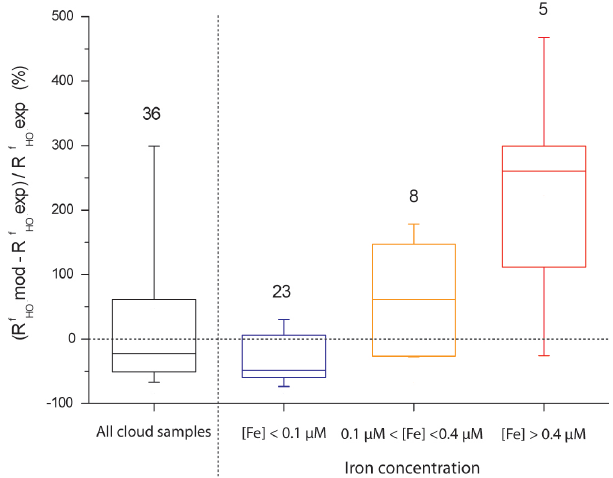
Figure 5. Distribution of the bias error for all cloud water samples Figure 4. Distribution of the bias error for all cloud water samples for the reference case and for two sensitivity tests performed with (black) and for cloud samples discretized as a function of different the model: (i) with the iron chemistry (photolysis of Fe(III) and iron concentration ranges (in colour). The bias error is defined by the Fenton reaction) neglected in the model; and (ii) with the iron (cid:113) mod − R f (cid:113) exp) /R f (cid:113) exp (in %). The number of the ratio ( R f chemistry neglected and the new photolysis rate constants obtained HO HO HO samples analysed is indicated above each boxplot. The bottom and from experimental measurements implemented in the model. The top lines correspond to the 25th and 75th percentiles, respectively. (cid:113) mod − R f (cid:113) exp) /R f (cid:113) exp bias error is defined by the ratio ( R f HO HO HO The full line represents the median values. The ends of the whiskers (in %).The number of samples analysed is indicated above each are the 10th and 90th percentiles. boxplot. The bottom and top lines correspond to the 25th and 75th percentiles, respectively. The full line represents the median values. The ends of the whiskers are the 10th and 90th